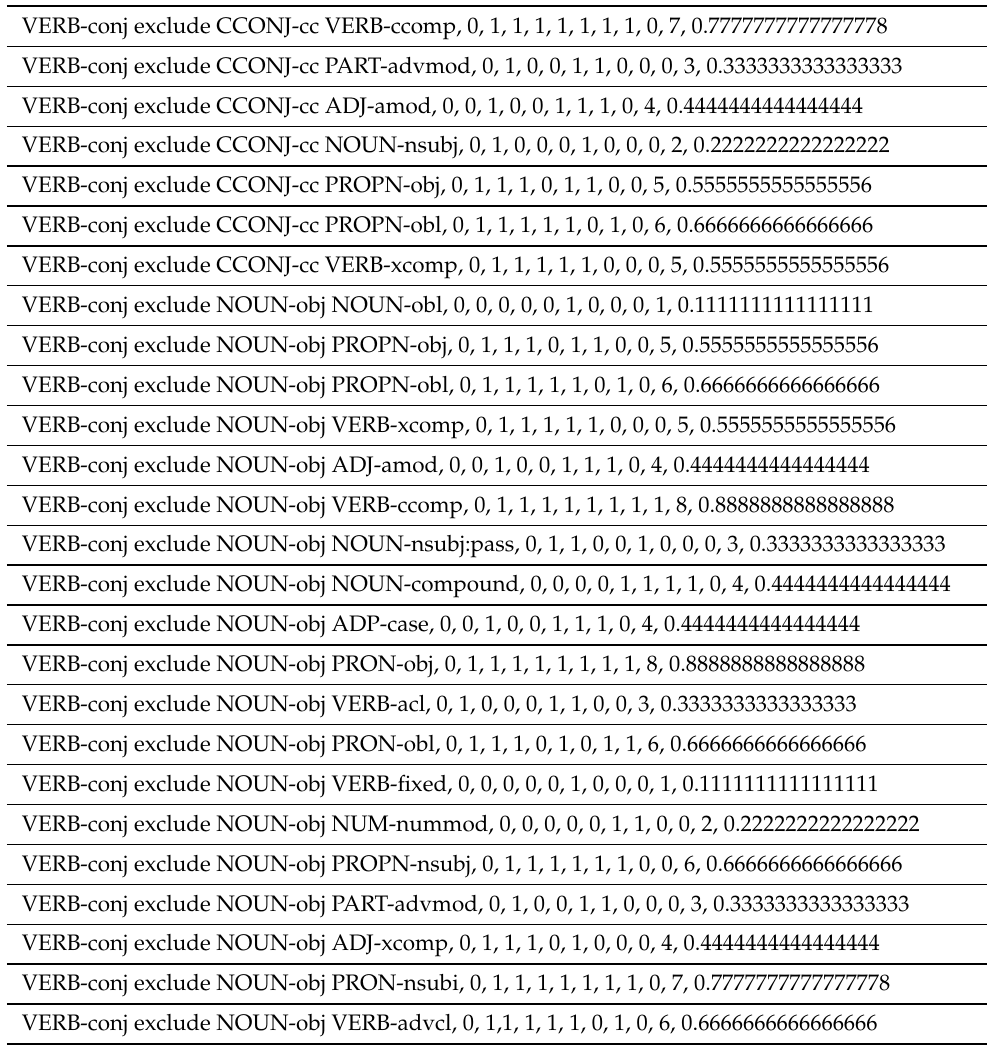
Table 2. Example of output of rules with universality